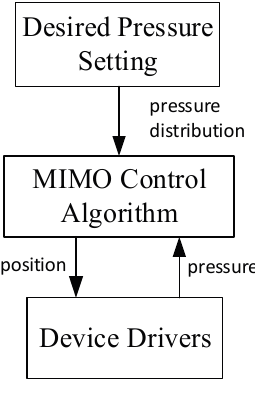
Figure 5. The proposed software architecture for pressure management.